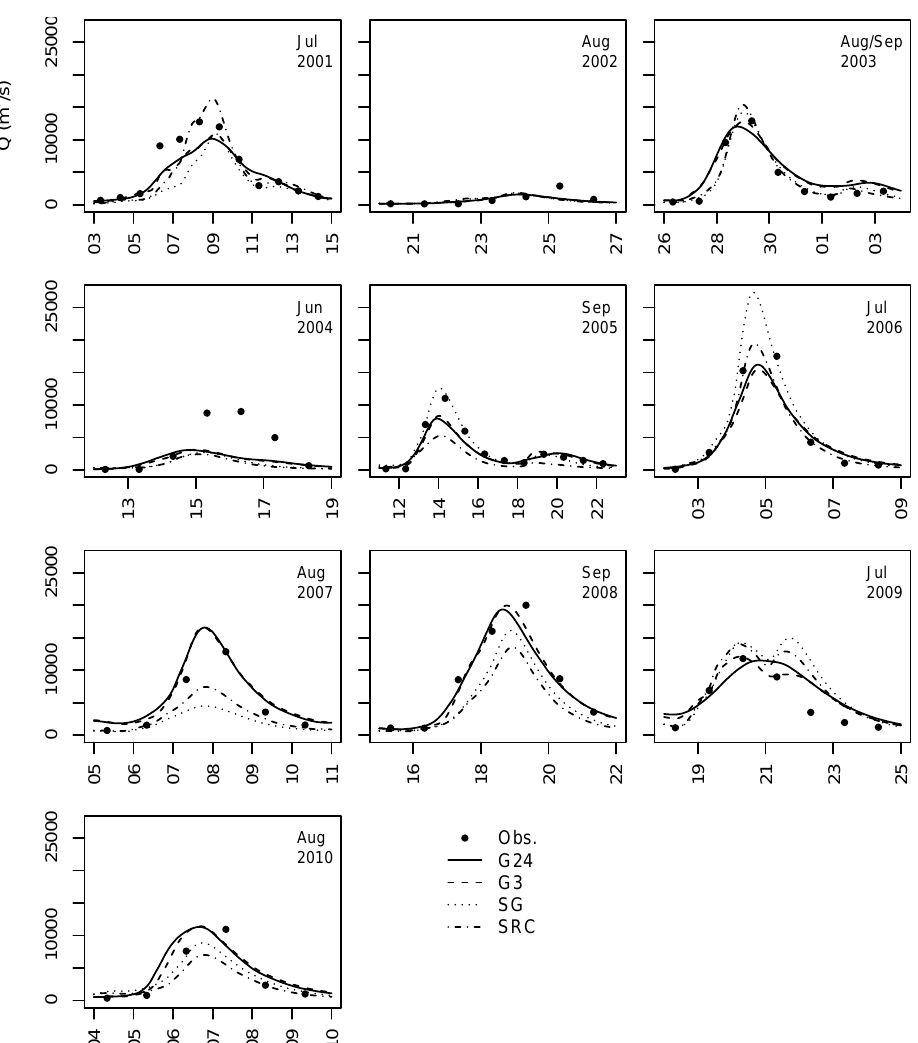
Figure 5. Observed and simulated stream flow at Kantamal (see Fig. 1, Table 5) for the annual floods in 2001–2010. All x axis labels represent the day of the month. All y axis with identical